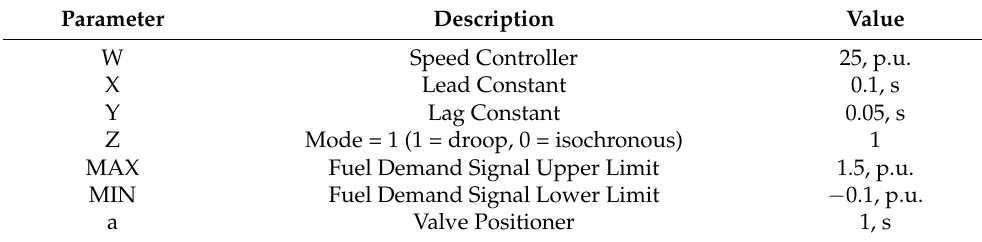
Table A1. Parameter values for micro gas turbine